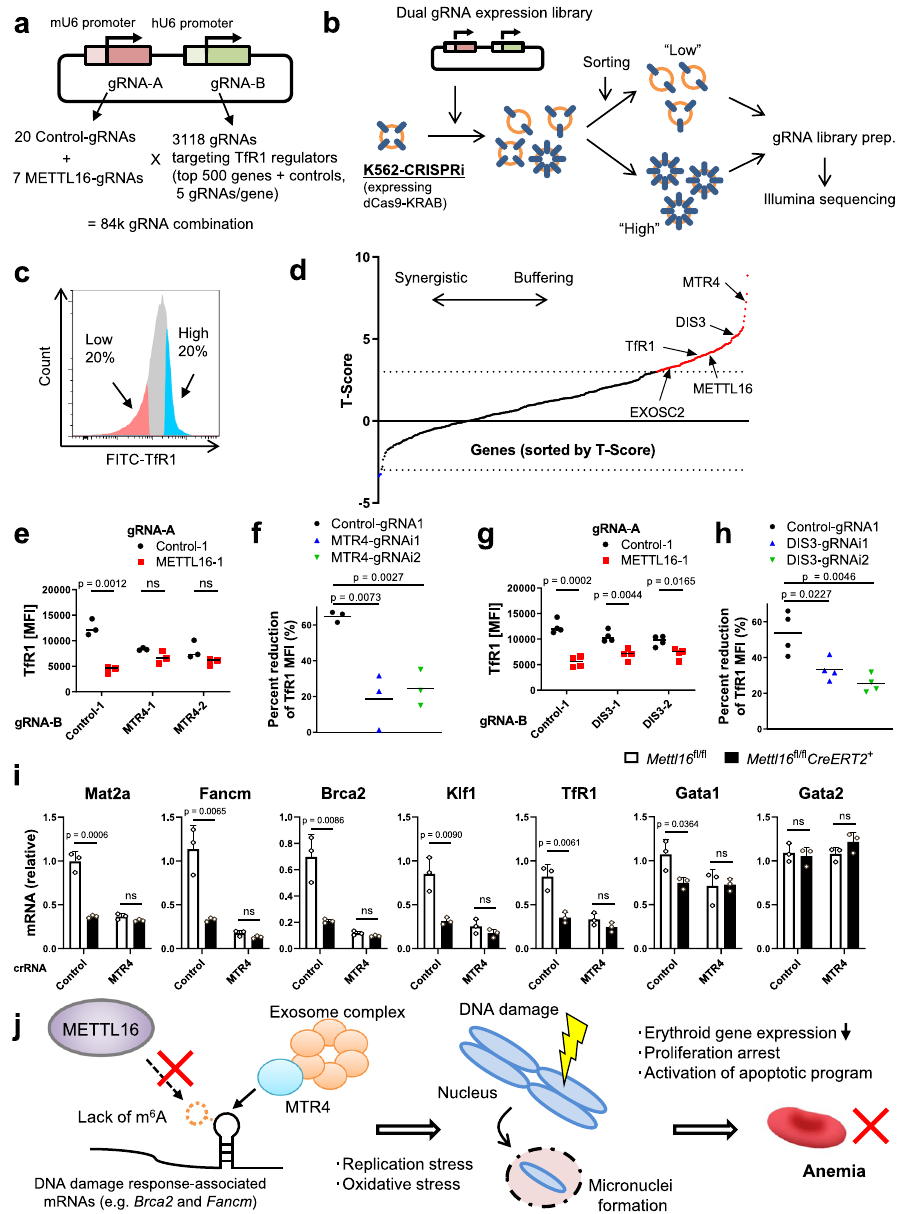
Fig. 6 | METTL16-mediated mRNA regulation requires MTR4-nuclear RNA exosome complex. a , b Work fl ow of the pairwise CRISPR screen for genetic interaction analysis. Top 500 TfR1 regulators were selected from the initial genome-wide CRISPR screen results. Then a dual gRNA expression library (M16GI) was constructed ( a ). K562-CRISPRi cells were transduced with the M16GI gRNA library and then cells were sorted according to the surface TfR1 expression ( b , c ). d Results of the pairwise CRISPR screen. Genes were sorted by T-score, which indicates the degrees of genetic interaction with METTL16. e – h Validation of the screen hits. Two gRNAs per gene were chosen for validation experiments. K562- CRISPRi cells were transduced with lentiviral vectors encoding individual dual gRNAs.ThencellsweretreatedwithDFOovernight,stainedwithanti-TfR1antibody andanalyzed using fl owcytometry( e , g ).ChangeinTfR1expressionlevels[(MFIof METTL16-suf fi cient cells − MFI of METTL16-de fi cient cells) / MFI of